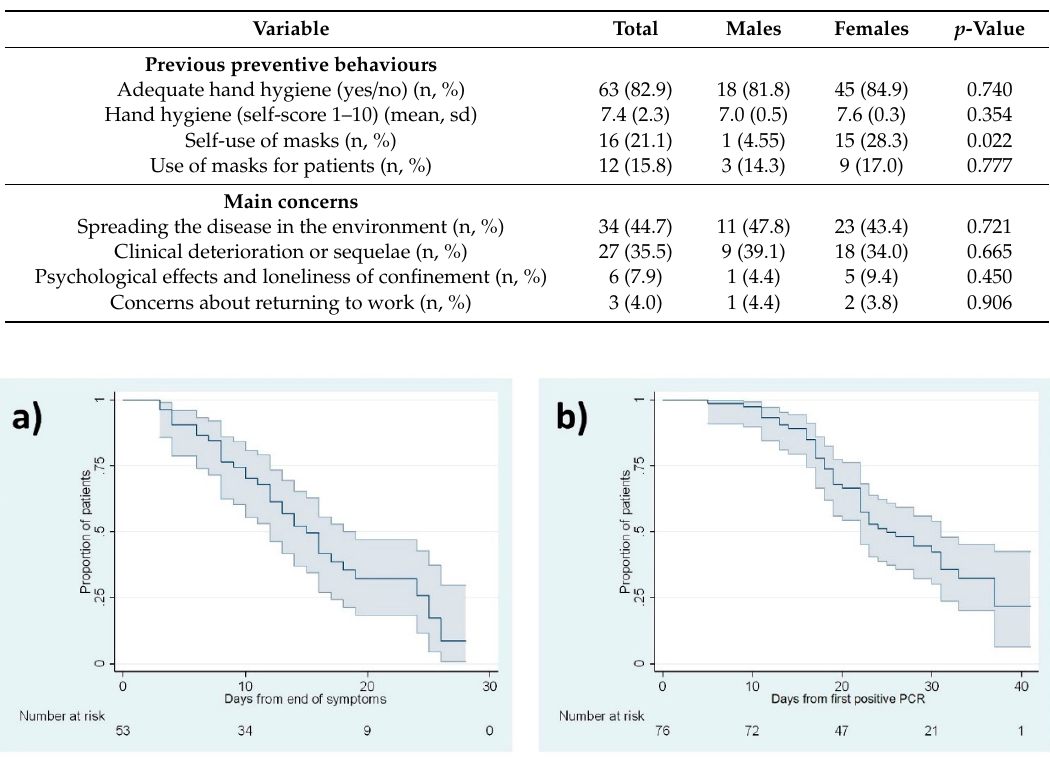
Table 2. Preventive behaviours prior to the COVID-19 pandemic and main concerns of health professionals during SARS-CoV-2 infection.